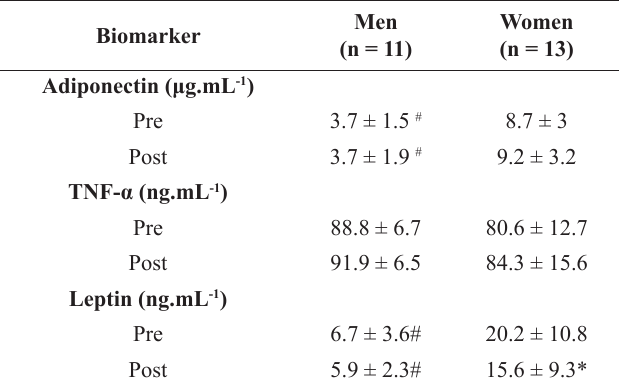
Table 3. Effects of two bouts of resistance exercise on adiponectin, leptin, and TNF-α levels in healthy women and